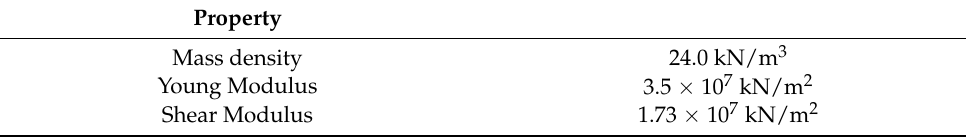
Table 2. Structural